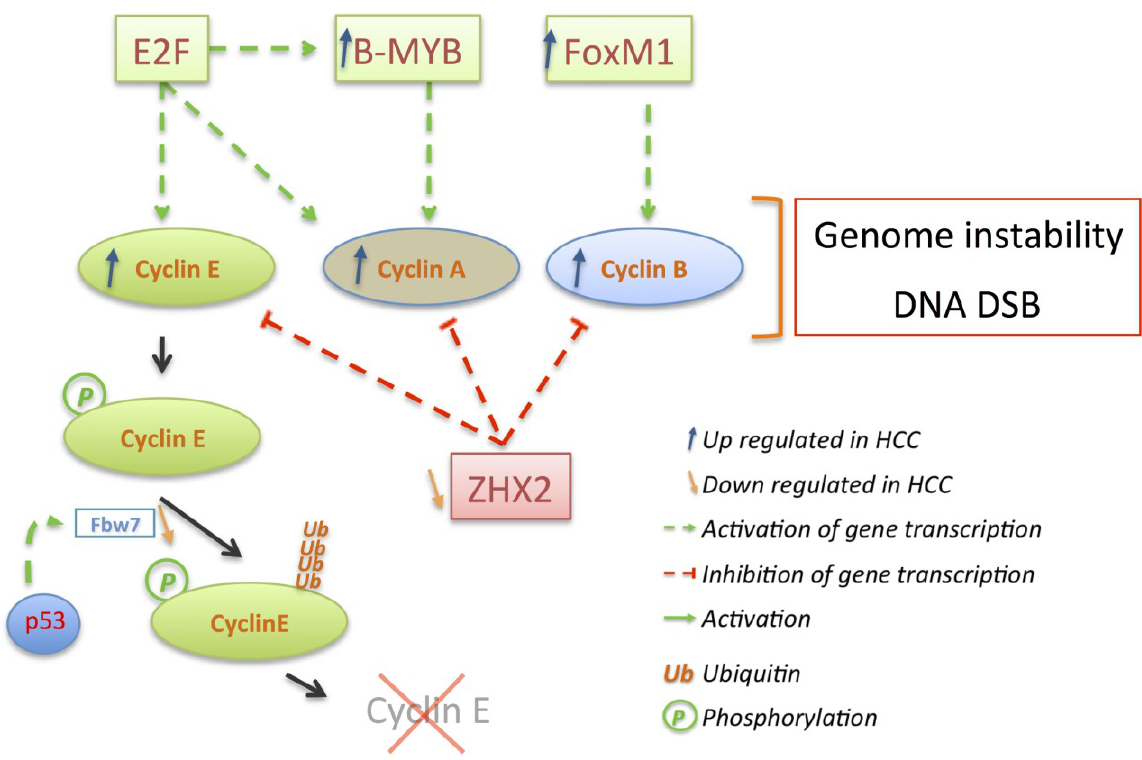
Figure 6. Cyclin E, A, and B overexpression triggers genome instability and DNA